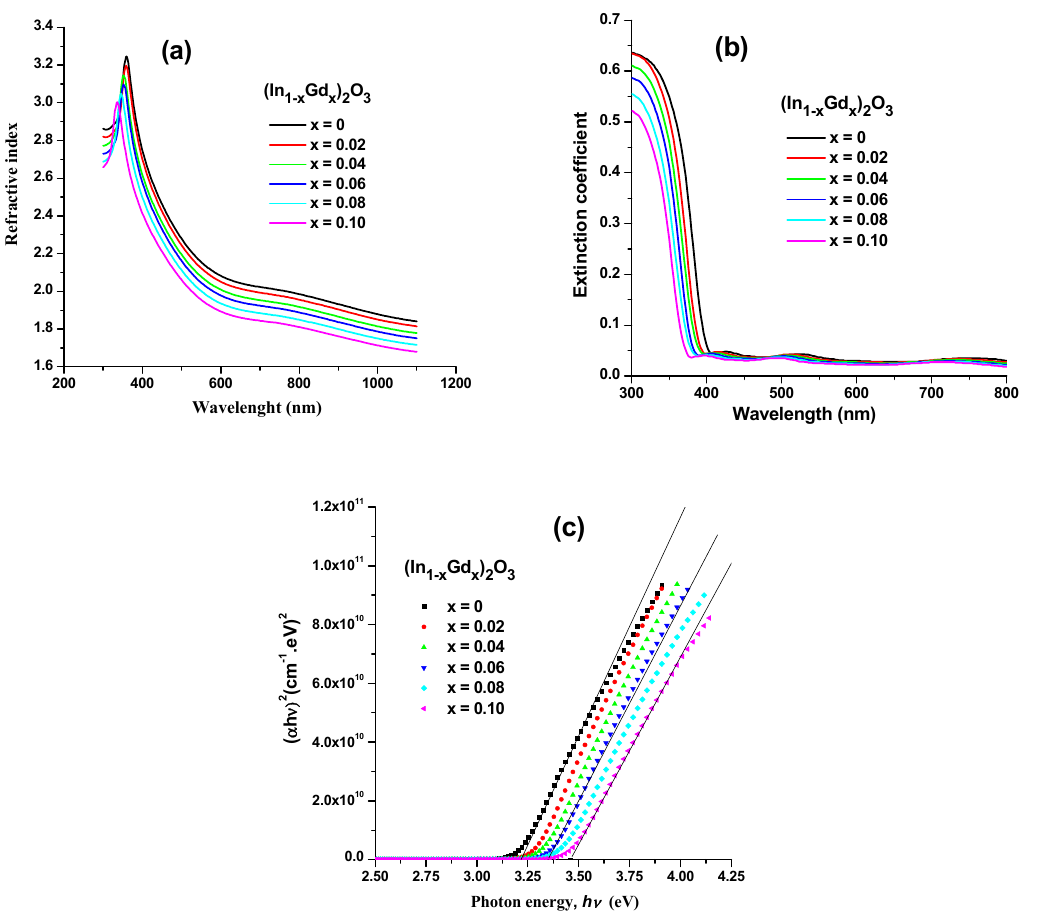
Figure 9. Spectra of ( a ) refractive index ( b ) the extinction coefficient for (In 1 − x Gd x ) 2 O 3 thin films and ( c ) plot of ( α h ν ) 2 versus h ν for (In 1 − x Gd x ) 2 O 3 thin films . When we schemed ( α h ν ) x vs. ( h ν ) for (In 1 − x Gd x ) 2 O 3 films with different Gd contents, a